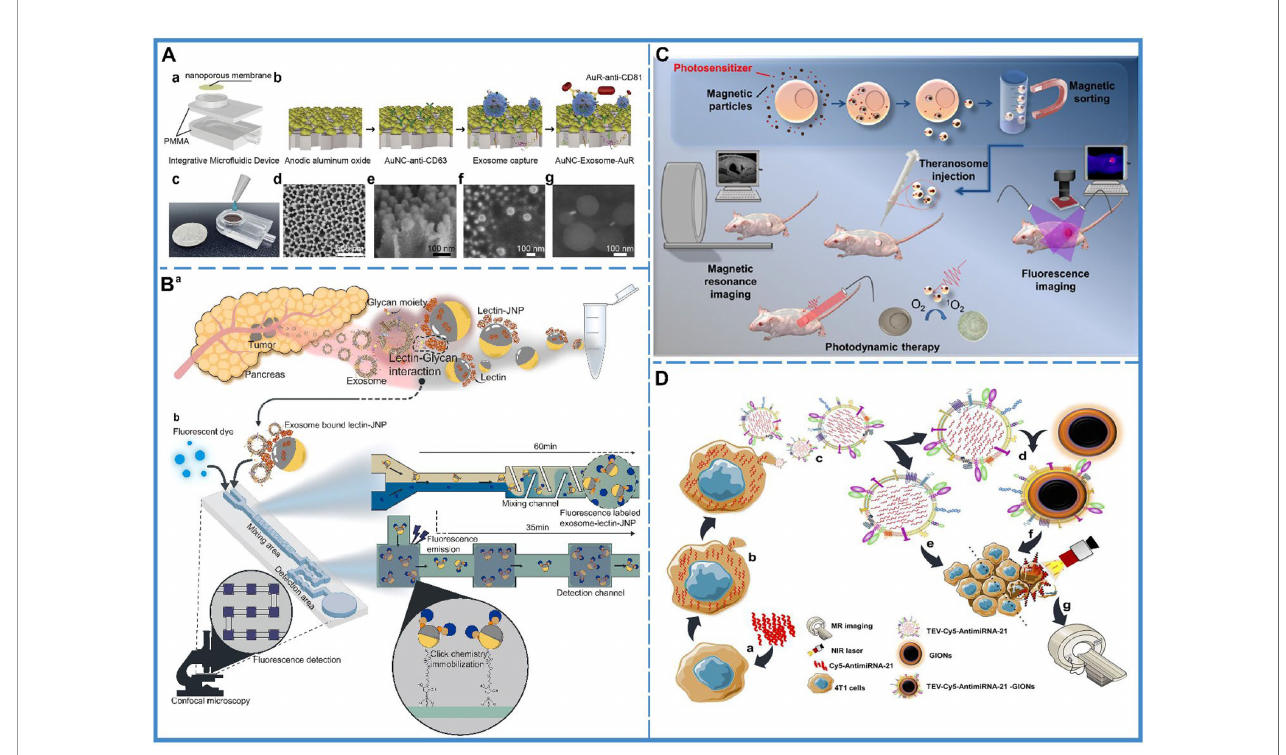
FIGURE 2 | Cancer diagnosis. (A) An integrative micro fl uidic device (IMD) for the isolation and detection of exosomes. (a) The model design of the IMD. (b) The in- situ detection of exosomes. (c) An image of the IMD. (d) A scanning electron micrograph of the Au nanoparticles deposited on a 50-mm-thick AAO membrane; side view presented in (e). (f) A scanning electron micrograph of the captured exosomes on the AAO membrane, and (g) A scanning electron micrograph of the AuNC- Exosome-AuR complex. Reproduced with permission from Ref (60). Copyright 2020 Elsevier. (B) Schematic illustration of the capturing of pancreatic cancer exosomes via Exo-chip system. (a) Isolation of the exosomes from the patient blood specimens/pancreatic cancer cell line culture medium. (b) After addition to the Exo-chip with Janus nanoparticles (JNPs), the sample was visualized via fl uorescence imaging and analysis. Lectin-conjugated JNPs mediate the interaction between exosomes and the chip substrate via click reactions (maleimide-functionalized JNPs and thiol-functionalized substrate) that bind the substrate in a laminar fl ow system. Reproduced with permission from ref (58). Copyright 2020 Elsevier. (C) Schematic illustration of the synthesis of tumor derived extracellular vehicles loaded Cy5 and antimiRNA-21 (TEVs-Cy5-antimiRNA-21) and TEVs-Cy5-antimiRNA-21-coated gold iron oxide nanotheranostics (GIONs). (a) Cy5-antimiRNA-21 was transfected into the donor 4T1 cells, (b) Cy5-antimiRNA-21-packed donor 4T1 cells, (c) In situ generation of 4T1 tumor cell-derived Cy5-antimiRNA-21-loaded extracellular vesicles, (d) Top-down fabrication synthesis of TEVs-Cy5-antimiRNA-21-coated GIONs, (e) TEVs-Cy5-antimiRNA-21-mediated cancer therapy, (f) TEVs- Cy5-antimiRNA-21-GIONs-mediated multimodal imaging and photothermal cancer therapy, (g) MRI of 4T1 cancer cells delivered by TEVs-Cy5-antimiRNA-21-GIONs. Reproduced with permission from ref (59). Copyright 2013 American Chemical Society. (D) Schematic representation of theranosome generation from drug-loaded magnetic precursor cells along with their application in photodynamic therapy and dual-mode MRI and fl uorescence imaging. Reproduced with permission from ref (66). Copyright 2018 American Chemical